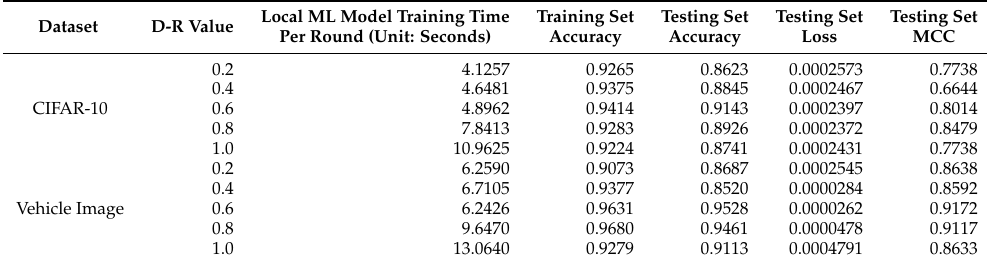
Table 4. Impact of different Diversity-Ratio